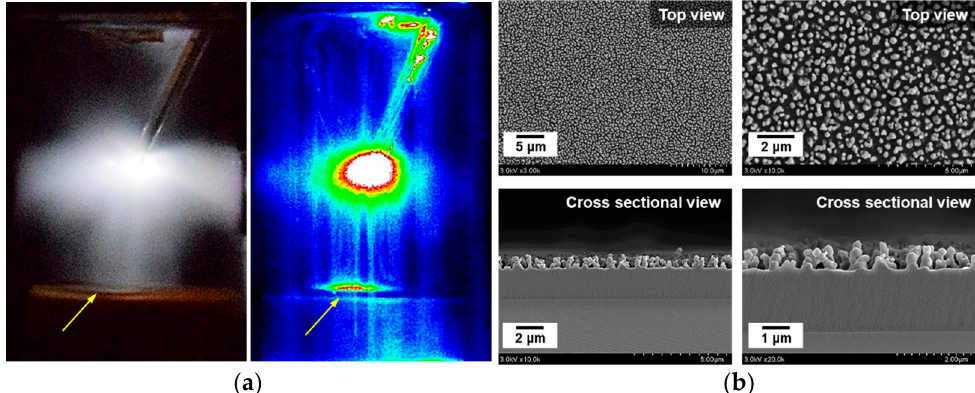
Figure 7. AP-plasma polymerization in the plasma coupling mode: ( a ) digital photograph and ICCD image of the generated glow discharges, and ( b ) SEM images of the resulting PANI film.